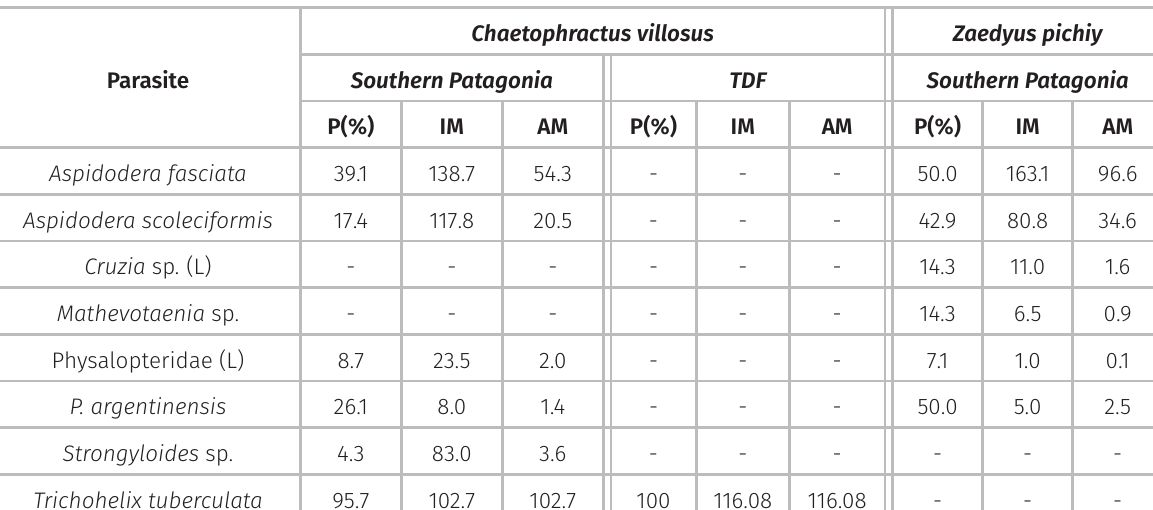
Table I. Prevalence (P), mean intensity (MI) and mean abundance (MA) estimated for the helminths found in armadillos from Patagonia. (Larvae stages are indicated with